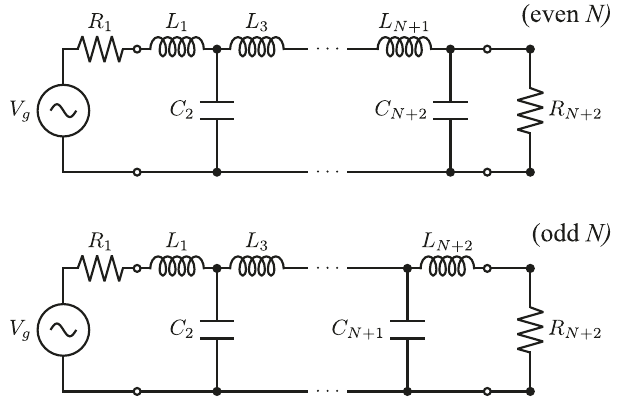
Fig. 7 | Diagrams for the numericalsearch ofthe optimized 1-stageparameters Fig. 5 | Butterworth fi lter network design. ( N +2)th order Butterworth fi lter net- h i to achieve the highest possible continuous-time two-way pure-loss capacity , and work with normalized circuit elements R 1 = R N +2 =1, L j =2sin ð 2 j (cid:3) 1 Þ π h i under the resonant assumption Δ a = Δ 2 = Δ b . a Contour plot of the continuous- 2 ð N +2 Þ such that ω cut =1 53 . C j =2sin ð 2 j (cid:3) 1 Þ π timetwo-waypure-losscapacityfor N =1, Q N =1 2 ,intheparameterspaceof κ a , κ b ,and 2 ð N +2 Þ g b , assuming g a = g max . b A slice in the parameter space with a symmetric external coupling rate κ a = κ b = κ . The white star represents the point at the maximally fl at parameters. c A slice in the parameter spacewith the saturated coupling condition g b = g max . The white star represents the point at the maximally fl at